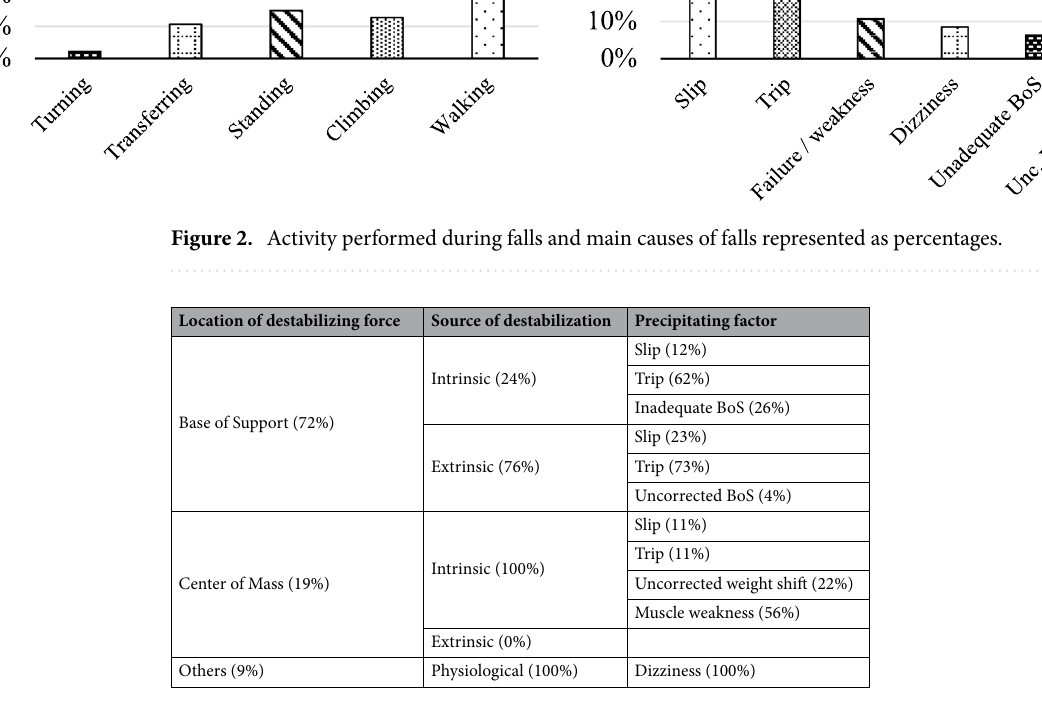
Table 3. Fall classification framework. Five of the 152 reported falls were not classified due to incomplete information.